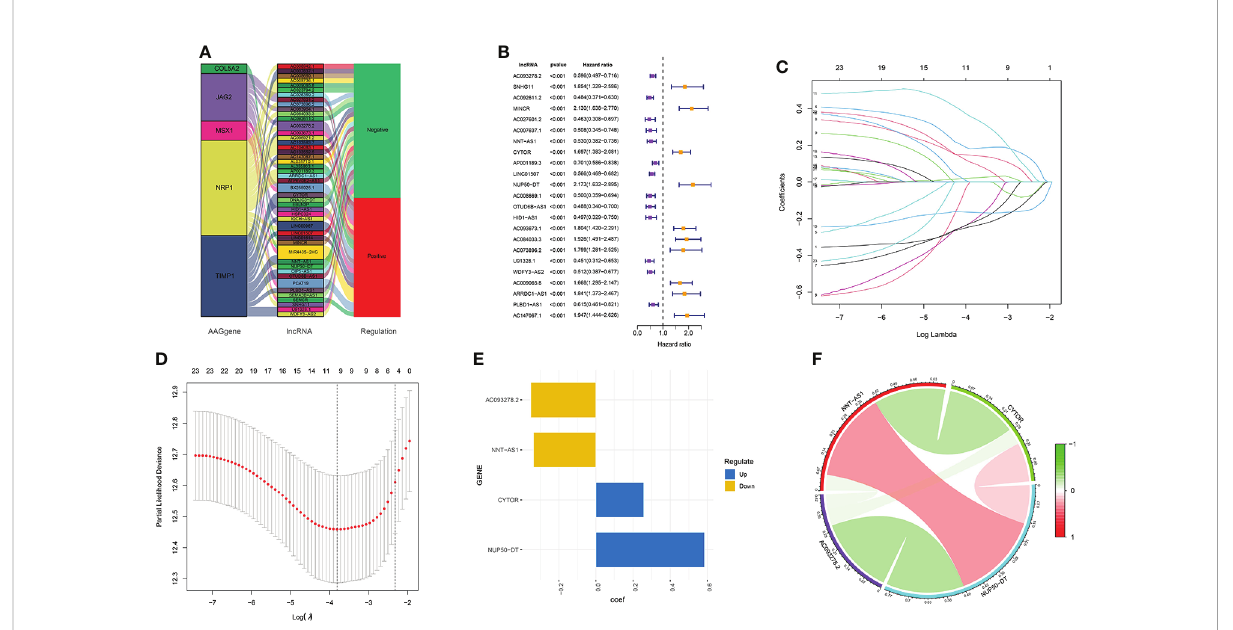
FIGURE 2 Screening of the four AAG-related prognostic lncRNAs. (A) Association between AAGs and targeted lncRNAs. (B) Univariate Cox regression analysis of 23 AAG-related lncRNAs ( p < 0.001). (C) LASSO coef fi cient pro fi les of 23 AAG-related lncRNAs. (D) LASSO regression with 10-fold cross-validation obtained nine AAG-related lncRNAs using a minimum lambda value. (E) Multivariate Cox regression of the four prognostic AAG-related lncRNAs. (F) Correlation analysis of the four AAG-related